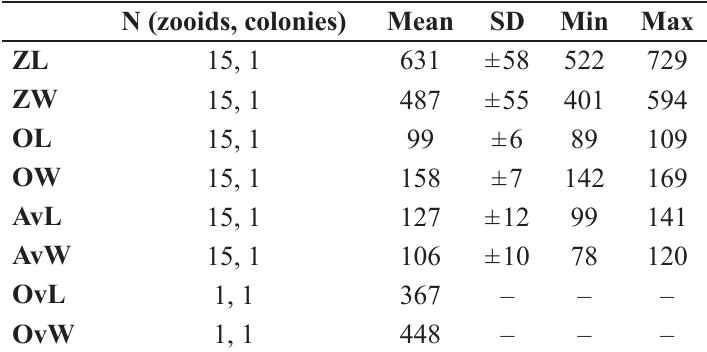
Table 6. Measurements in µm of Microporella ordoides sp. nov., Recent, NZOI St. D35, New Zealand; holotype NIWA